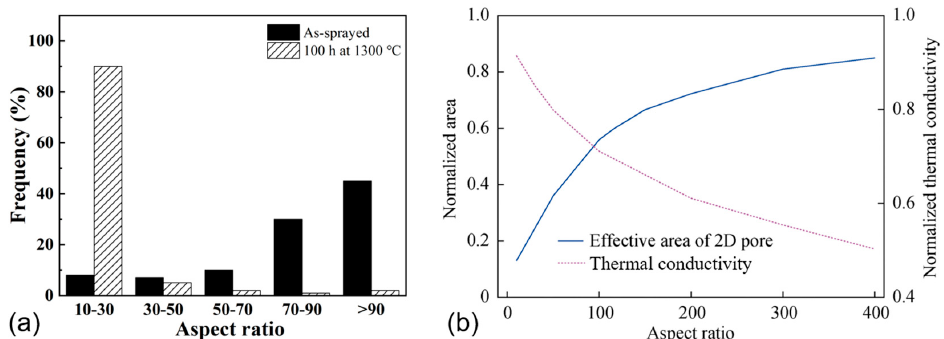
Figure 18. ( a ) Aspect ratio distribution of interlamellar 2D pores in APS-TBC exposed at 1300 °C for different durations ( b ) relationship between the pore normalized area, normalized thermal conductivity, and aspect ratio (adapted from [103,109] ).